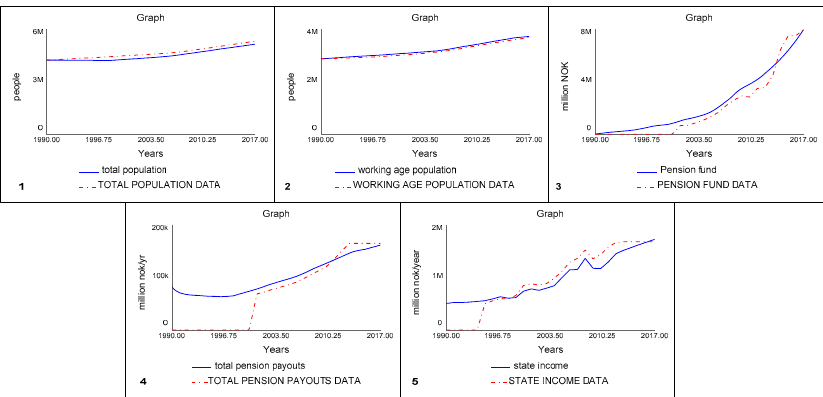
Figure A1. Reference points used for validation. 1 = total Norwegian population (persons/year); 2 = working age population (persons/year); 3 = Norwegian pension fund (Pension Fund Global) (million NOK/year); 4 = pension transfers (million NOK/year); 5 = state income (million NOK/year). All simulations are in blue, and all historical data are in red.